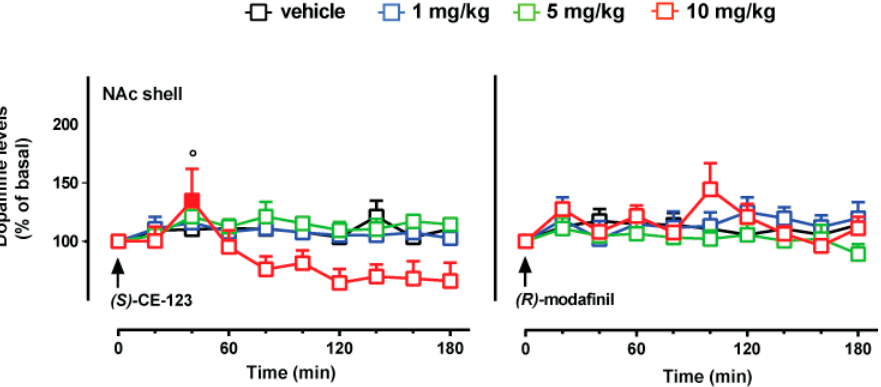
Figure 4. E ff ect of ( S )-CE-123 and R -modafinil on dopamine transmission in the NAc shell. Graphs showing the e ff ects of ( S )-CE-123 (left) or R -modafinil (right) on dopamine levels in the shell of the NAc. The arrow indicates i.p. injection of ( S )-CE-123 or R -modafinil at the dose of 1 mg / kg (blue), 5 mg / kg (green), 10 mg / kg (red) or vehicle (black). Results are presented as mean ± SEM of change in dopamine extracellular levels expressed as the percentage of basal values. Solid symbol: p < 0.05 with respect to basal values; ◦ p < 0.05 ( S )-CE-123 10 mg / kg vs. R -modafinil 10 mg / kg (( S )-CE-123 n = 21; R -modafinil n = 15). Three-way ANOVA, Tukey’s post